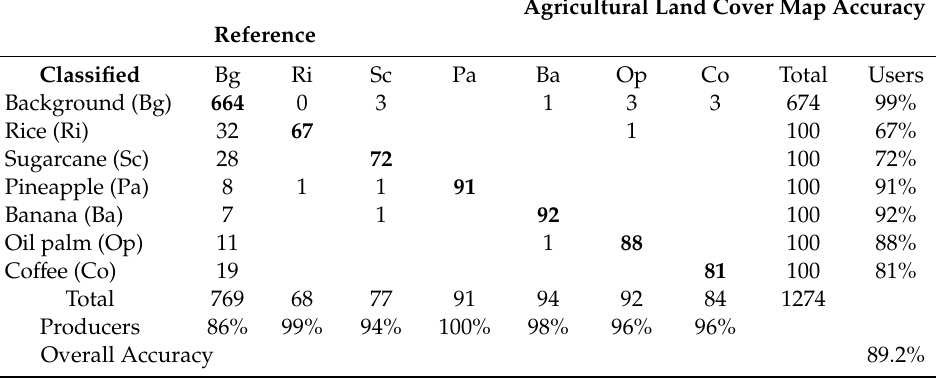
Table A3. Accuracy assessment for the 2015 agricultural land cover map, showing the original reference data. Agricultural testing points (n = 1274) were located through a stratified random sampling design. See Table 3 for the area-corrected accuracy